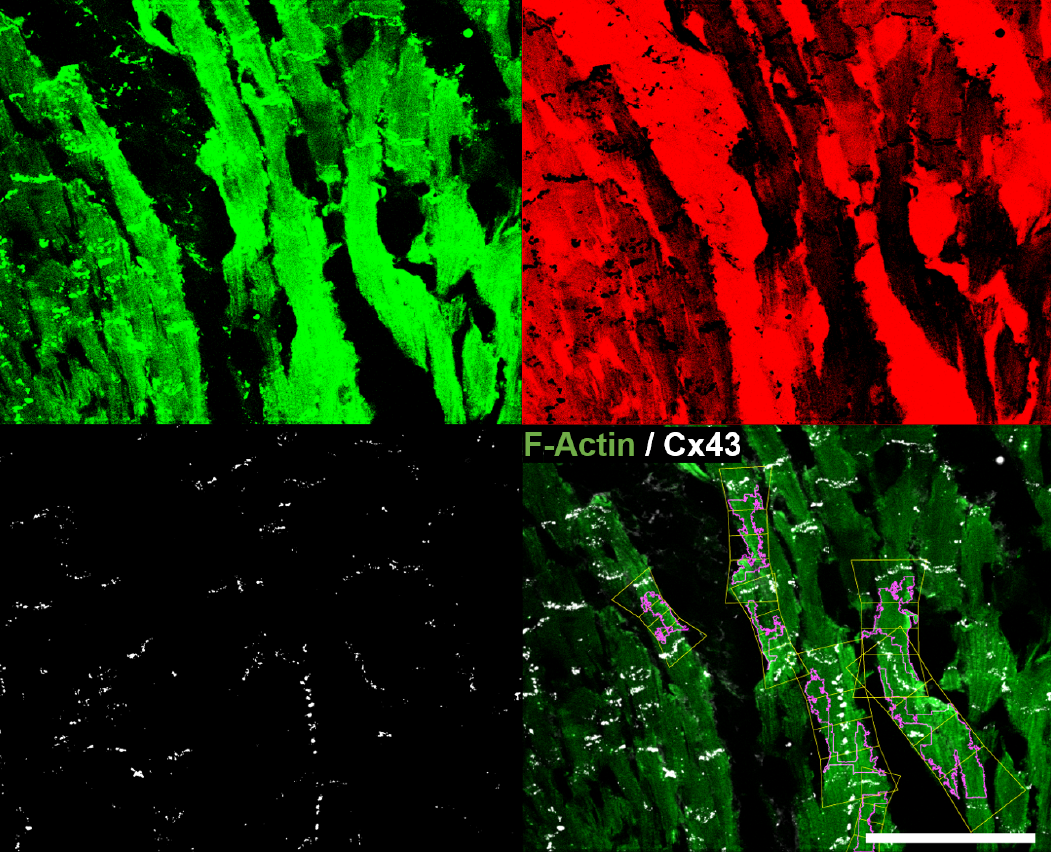
Figure 15. Binarized channels representing the CM mask M c 1 ( top left , in green), the interstitium generated by inverting the CM mask ( top right , in red) and the CX43 mask M c 2 ( bottom left , in white), as well as original image e with overlaid CMs detected in supervised mode ( bottom right ). Scale bar = 100 µ